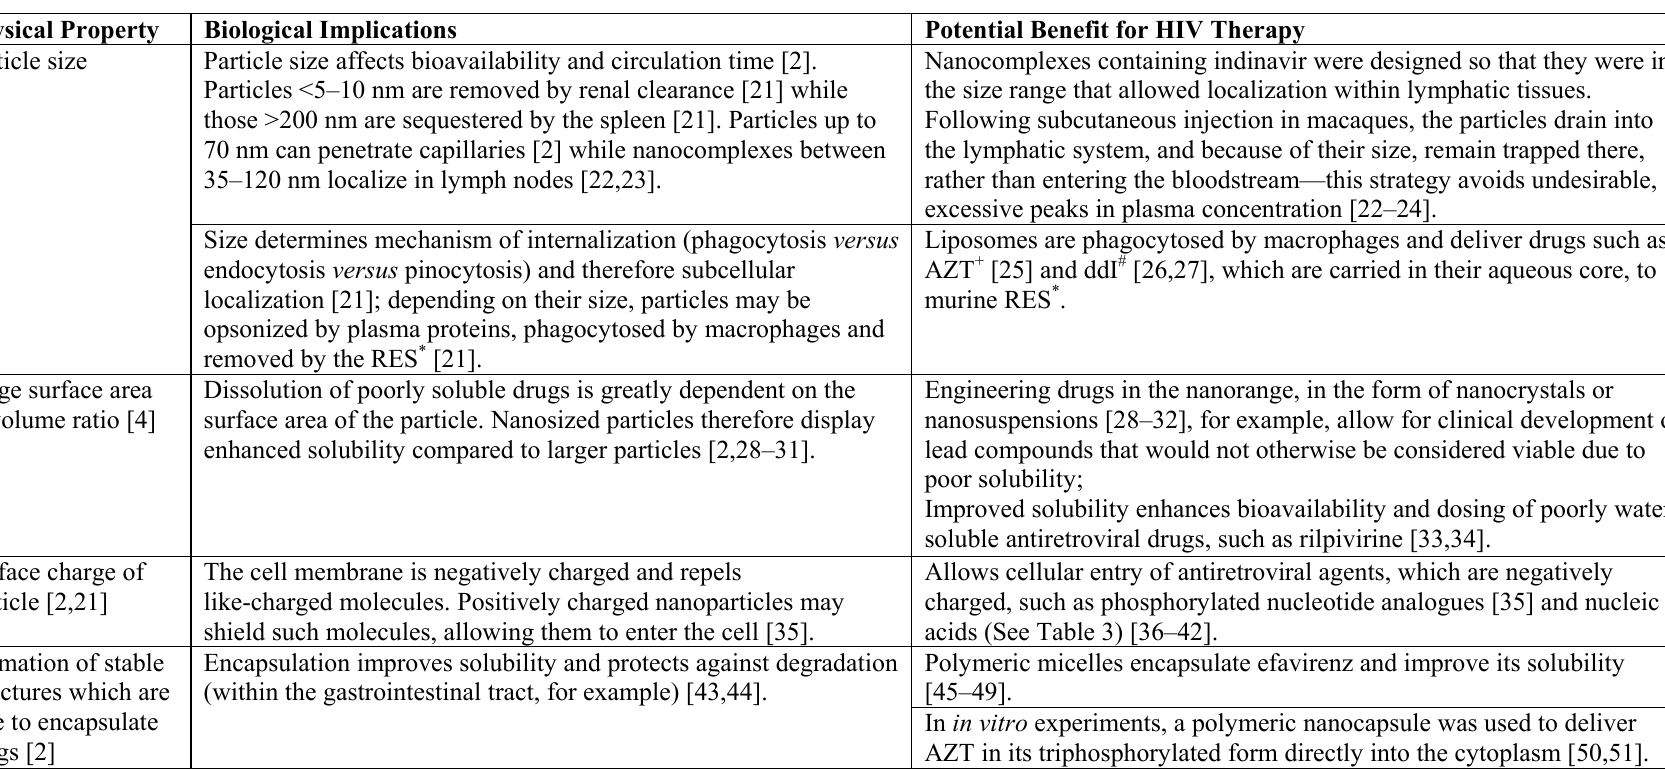
Table 1. Examples of how the physical properties of nanoparticles have biological consequences that may benefit HIV therapy [1,2,19,20]. Physical